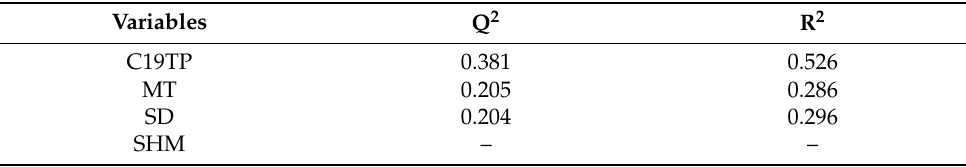
Table 10. Coefficient of determination (R 2 ) and Stone–Geisser test (Q 2